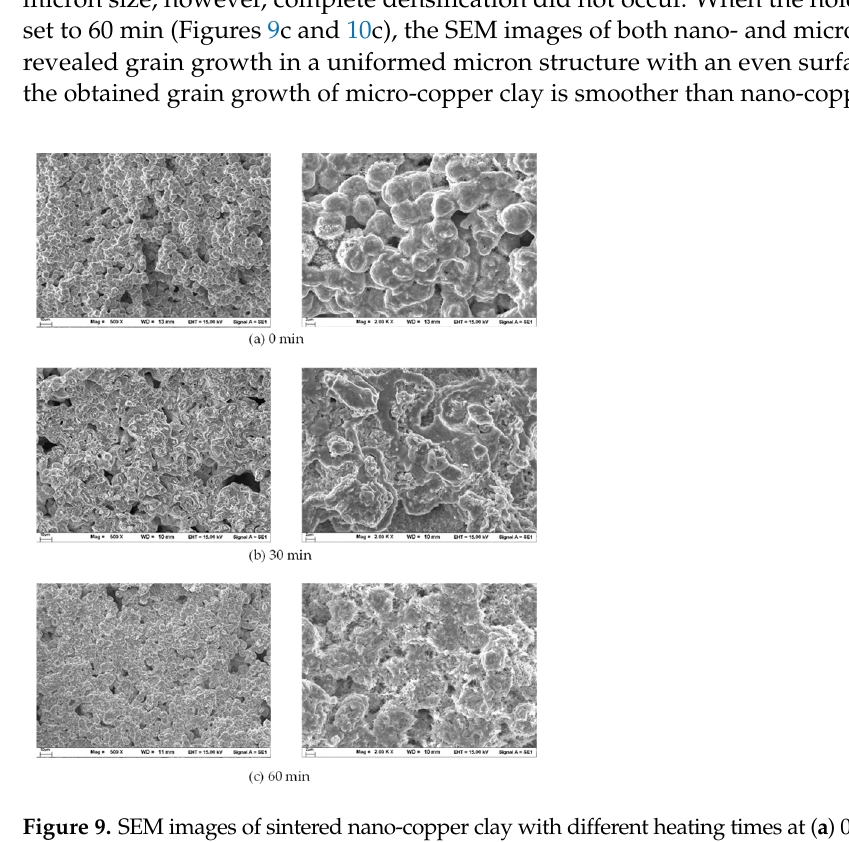
Figure 10. SEM images of sintered micro-copper clay with different heating times at ( a ) 0 min, ( b ) 30 min, and ( c ) 60 min. Figure 11a shows the extent of holding times, which increase the volume shrinkage in both nano- and micro-copper clays. At 0 min of holding time, nano- and micro-copper